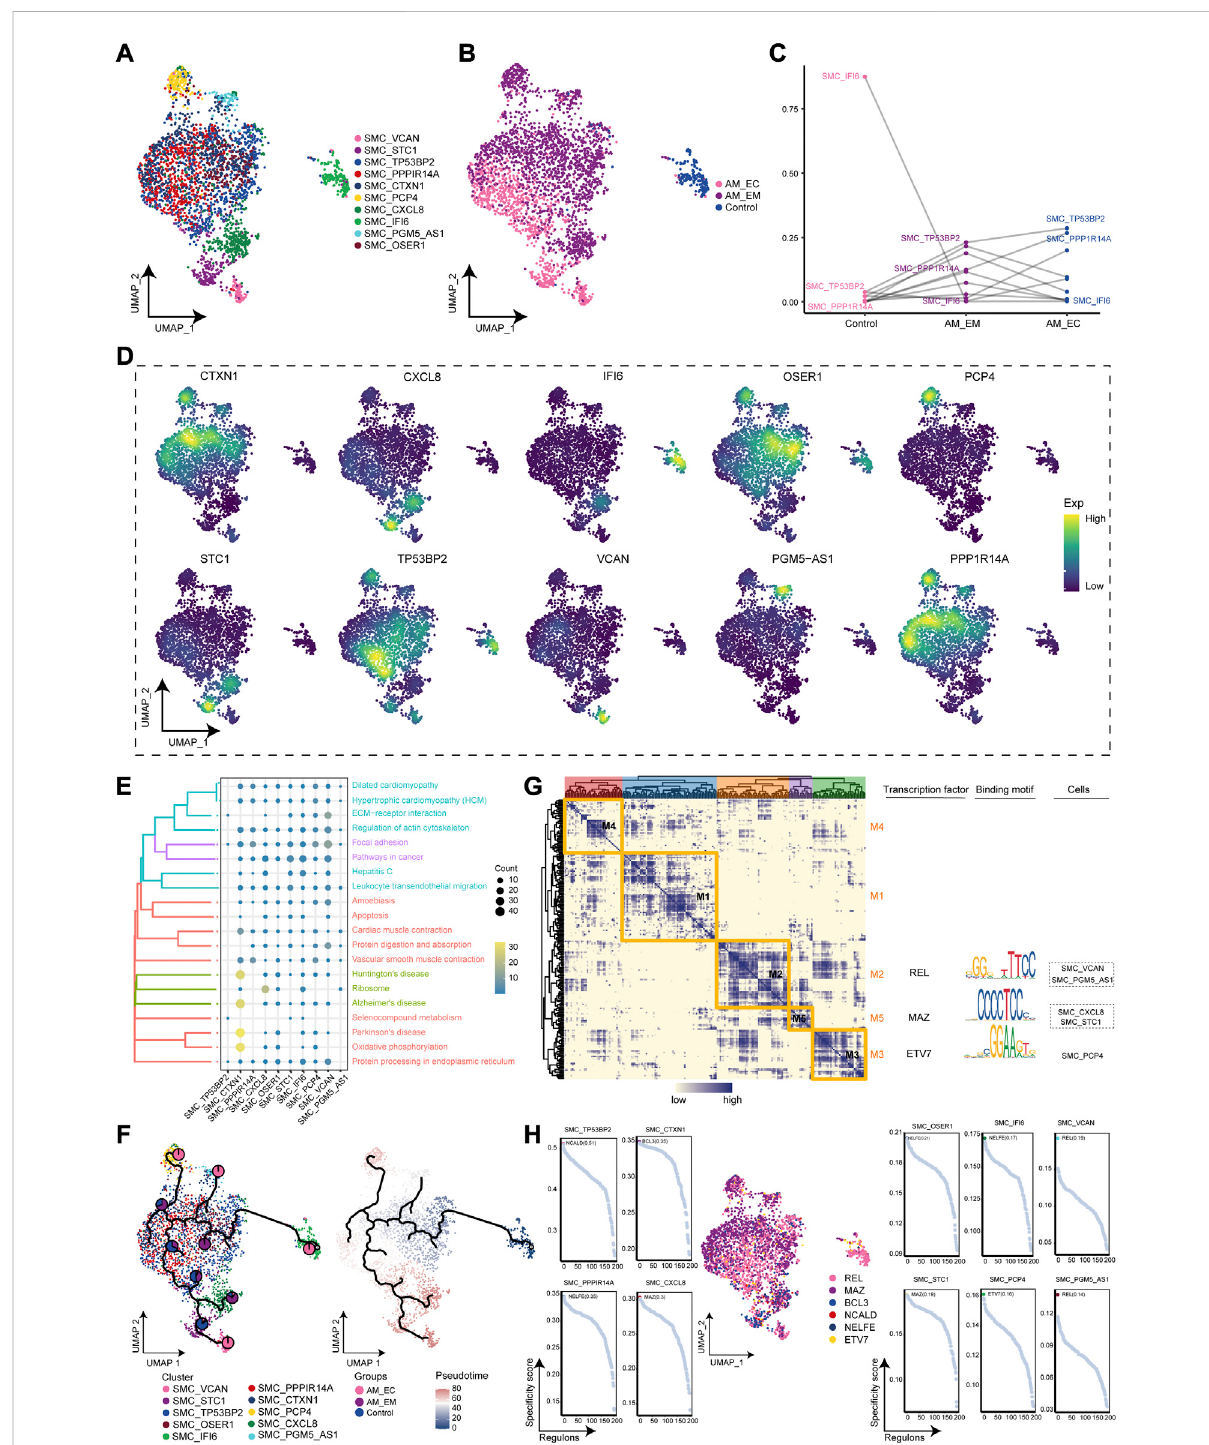
FIGURE 5 AM-relatedsmoothmusclecell(SMC)clusters (A) .Single-cellatlasmapsthecellclustersofSMC. (B). Single-cellatlasshowsdifferentgroupsof SMC clusters. (C). Differences in the cellular ecology of SMC clusters in different groups. (D). Marker genes for speci fi c SMC clusters. (E). Biological pathways are signi fi cantly involved in the SMC clusters. (F). Single-cell atlas maps the evolutionary trajectories of SMC subgroups in AM. Pie charts showtheproportionofthedifferentgroupsinthesubgroup. (G) .TranscriptionfactorsforclustersofSMC inaco-expression pattern.Left:Heat map identi fi es co-expression modules; middle: major transcription factors and their binding sequences; right: cell clusters of transcription factors. (H). Scatter plots showed transcription factors in clusters of SMC. AM_EM, eutopic endometrium; AM_EC, ectopic endometrium; SMC, smooth muscle cell; UMAP, Uniform Manifold Approximation and